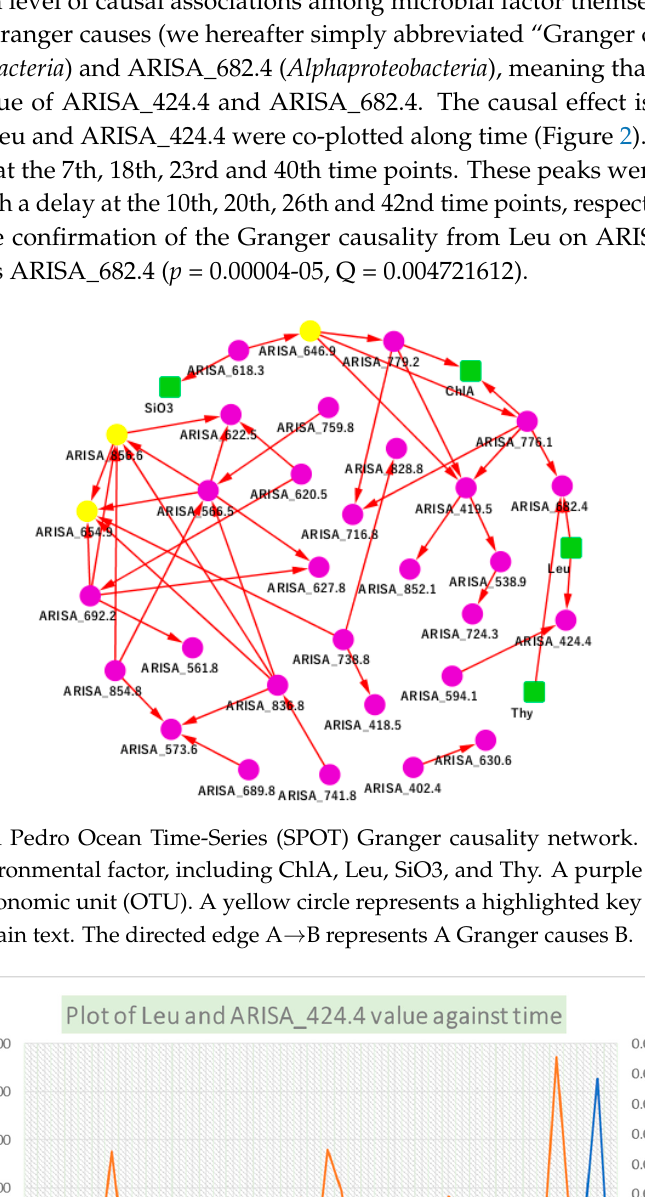
ARISA_424.4 level with a delay at the 10th, 20th, 26th and 42nd time points, respectively. The observed pattern is an intuitive confirmation of the Granger causality from Leu on